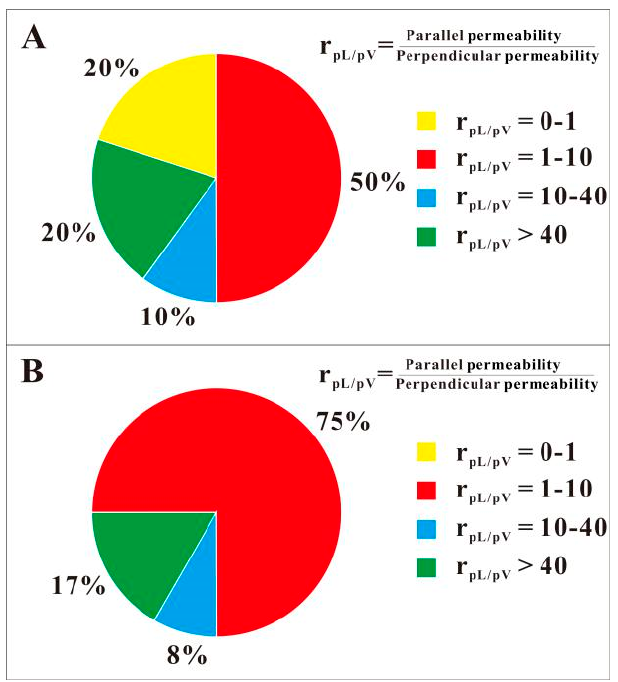
Figure 5. Ratio statistics between parallel and perpendicular permeability. ( A ) Samples of Wangyinpu and Guanyintang Formations shale from the Jiangye-1 and Jiangye-2 wells; ( B ) samples of Longmaxi Formation shale from the Pengye-1 well. The sample information can be seen in Table 2.